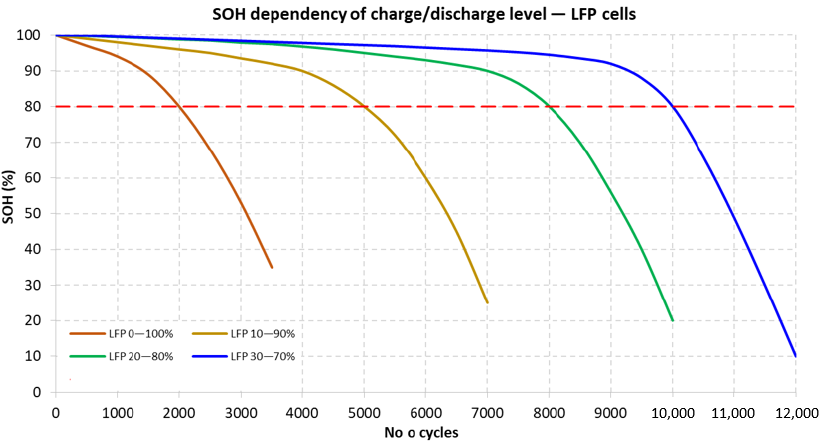
Figure 1. Loss of capacity of Winston WB–LYP160Aha cells as a function of the number of cycles for different operating ranges.